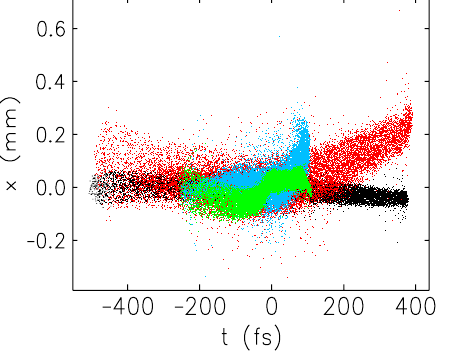
FIG. 12. Horizontal position along the bunch at 2244 MeV (black—after linac second pass; red—after extraction; blue— after bunch compressor 3; green—after spreader and on entrance to